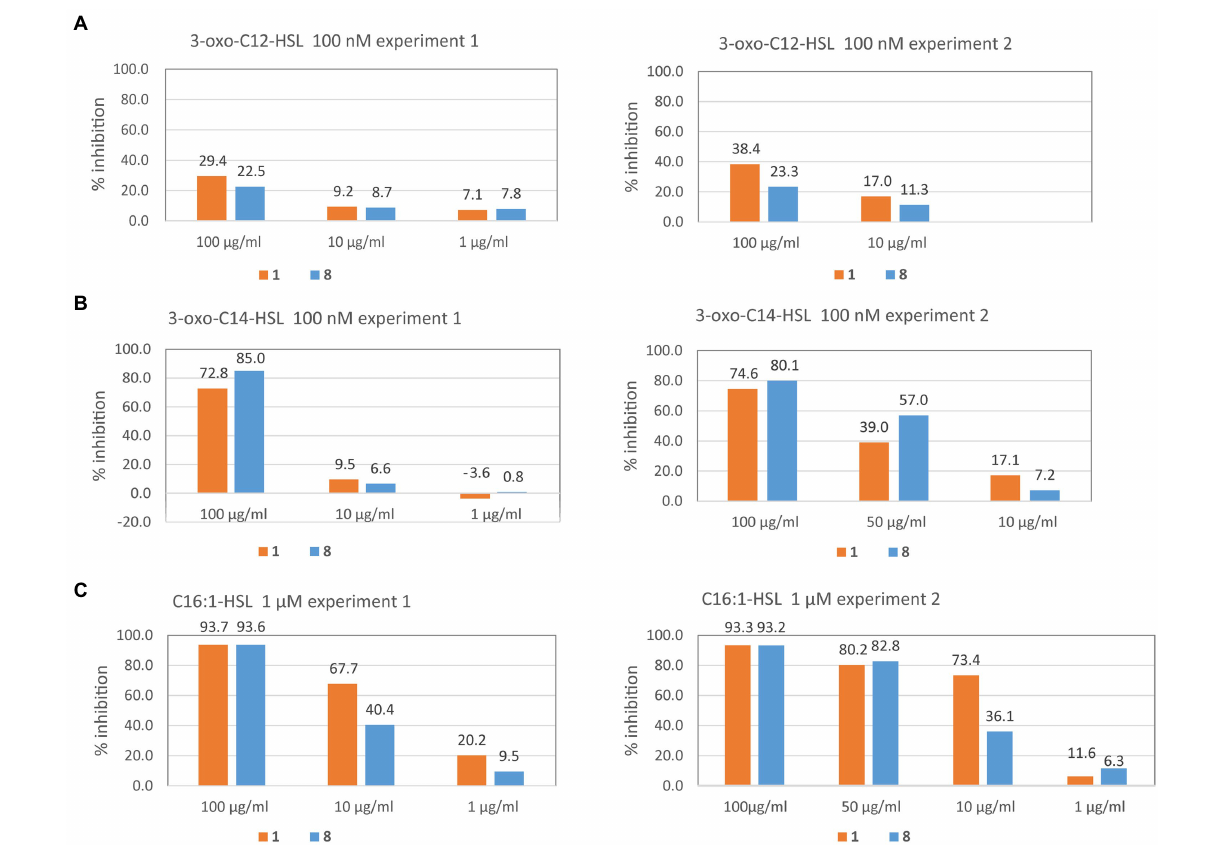
FIGURE 4 Inhibition of QS by volatiles from OMVs of Dinoroseobacter shibae . QS was induced in the sensor strain Pseudomonas putida F117 (pKRC12) by 3-oxo- C12-HSL (A) , 3-oxo-C14-HSL (B) , or C16:1-HSL (C) and inhibition by ( Z )-5-dodecenal ( 8 ) and ( Z )-5-dodecenoic acid ( 1 ) is shown in % of control without inhibitor. The experiment for each QS inducer was performed twice (experiment 1 and experiment 2) and the inhibitor concentrations tested in the second experiment were sometimes modified based on the results found in the first experiment to provide a finer resolution. For example, for inducer 3-oxo-C14-HSL (B) we did not test 1 μ g/ml of inhibitor in the second experiment, because no activity was found in the first experiment, but tested 50 μ g/ ml instead. Each QS test was conducted by measuring green fluorescence of the test strain P. putida F117 pKRC12 in 10 parallel wells under the respective condition every hour (except at night) for 24 h. For each timepoint, mean and standard deviation of inhibition from 10 replicate wells are provided in Supplementary Table S1 for both experiments. Here we show % inhibition after 24 h. Standard deviation is below 0.1% and therefore would not be visible on the graph. Inhibition of 100 nM 3-oxo-C12-HSL by 1 μ g/ml of inhibitors was not measured. See methods for further